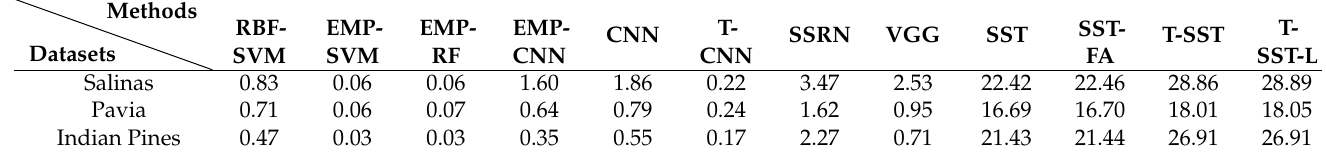
Table 8. Running time (min.) of different methods on the three HSI datasets with 200 training samples. DatasetsMethods RBF-